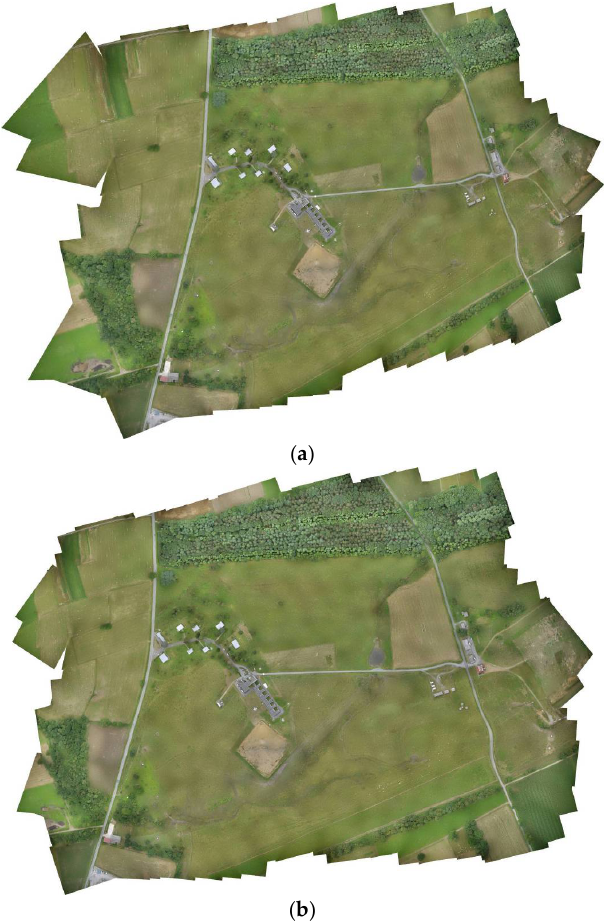
Figure 8. Mosaicking result of Dataset 4: ( a ) mosaicking result via Capel’s method; and ( b ) mosaicking result using the proposed algorithm.